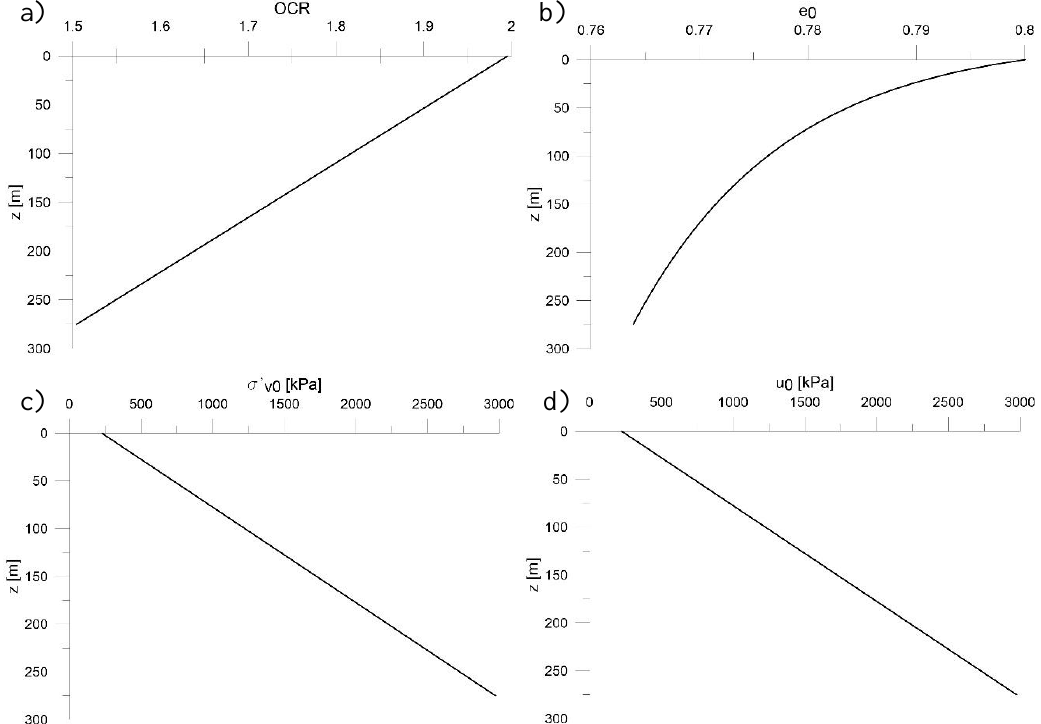
Figure 22. Initial conditions of modelled soil, ( a ) initial over consolidation ratio OCR; ( b ) initial void index e 0 ; ( c ) initial effective vertical stress σ ’ v,0 ; ( d ) initial pore pressure u 0 .